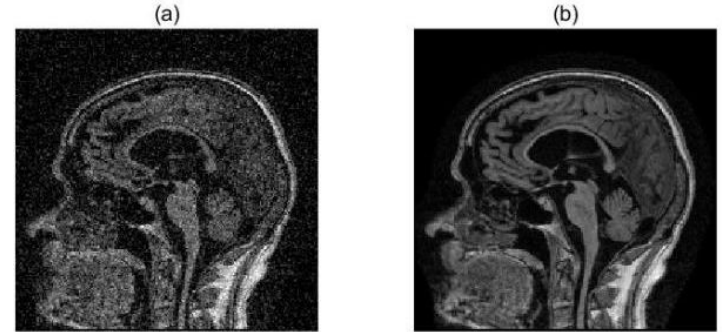
Figure 8. ( a ) Image before denoising. ( b ) Image after denoising.